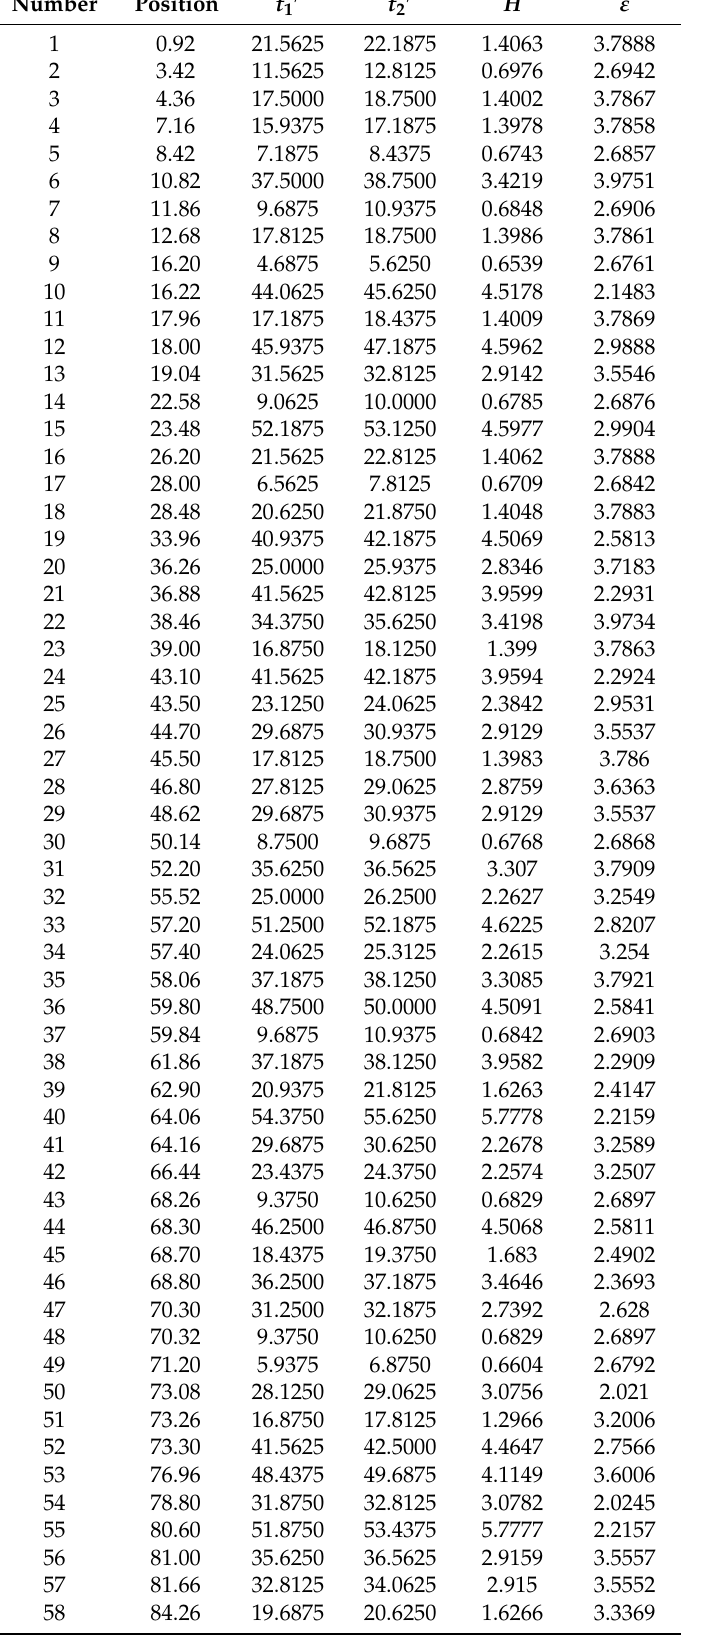
Table A3. Estimated parameters of LPR